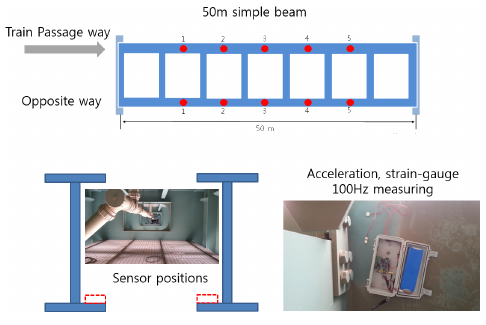
Figure 3. Structural health monitoring (SHM) system locations and components.